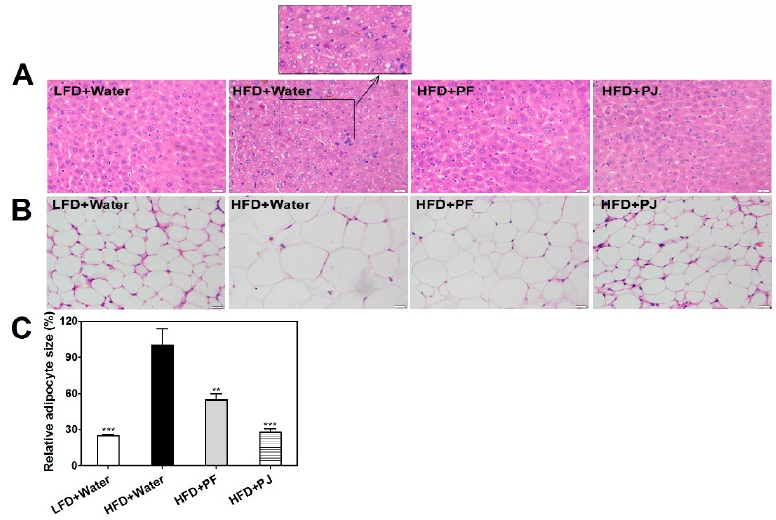
Figure 3. Effects of PF and PJ extracts on morphological changes (×200) in liver ( A ) and epididymal